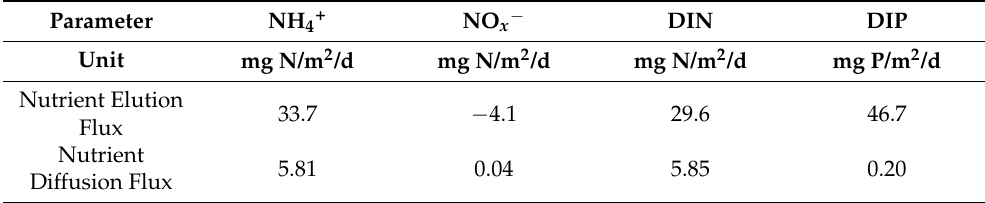
Figure 8. Results of the ex situ incubating experiment for eluted nutrients from the surface sediment toward overlying water at GA4, Gamak bay, Korea: ammonium-nitrogen (NH 4+ ) ( ● , dotted line); nitrite nitrogen and nitrate nitrogen (NO x − ) ( ○ , dashed line); dissolved inorganic phosphorous (DIP) ( ▲ , solid line). Table 2. Estimated nutrient elution and diffusion fluxes at the bottom seawater–surface sediment interface with reducing conditions due to anoxic water at GA4, Gamak bay, Korea.